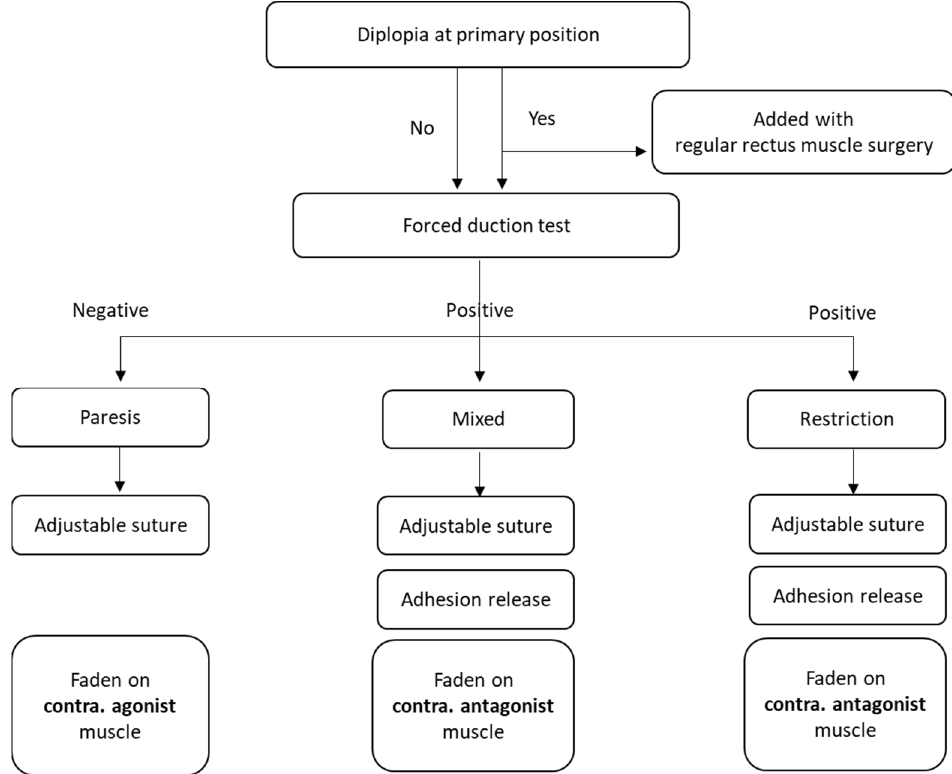
Figure 1. Protocol for the management of consecutive strabismus after orbital reconstruction for orbital fractures. Briefly, patients were tested to determine whether diplopia was present at the primary position, and regular rectus muscle surgery was performed to correct misalignment at the primary position if needed. A forced duction test was then performed for all patients on an outpatient basis to obtain a temporary diagnosis and in the operating room to obtain the final diagnosis. The subsequent surgical strategy was designed according to the pathological mechanism of the consecutive strabismus.